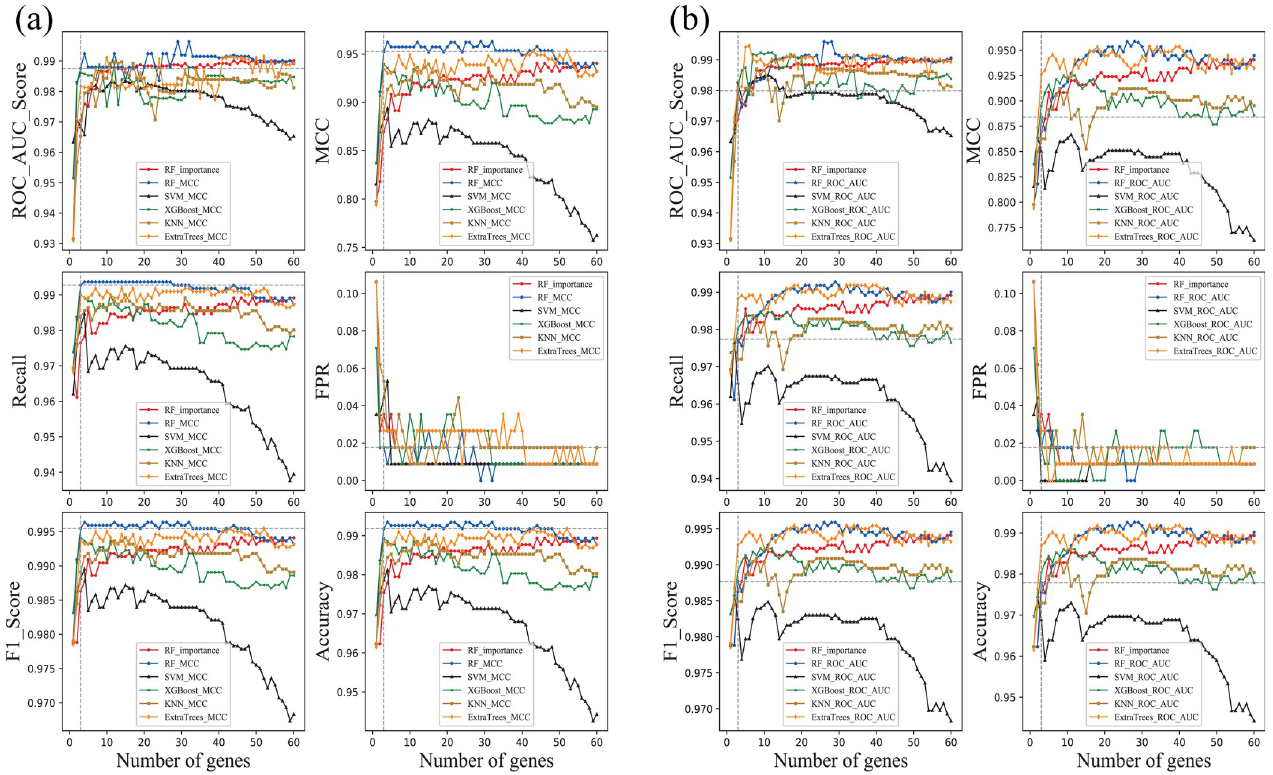
Fig 7. Polylines of classification metrics at the 19th iteration of the Sort Difference Backward Elimination (SDBE) algorithm. (a) MCC as the object of difference analysis. (b) ROC_AUC_score as the object of difference analysis. Various metric lists from stage 1 of the algorithm were illustrated by red polylines (RF_improtance).